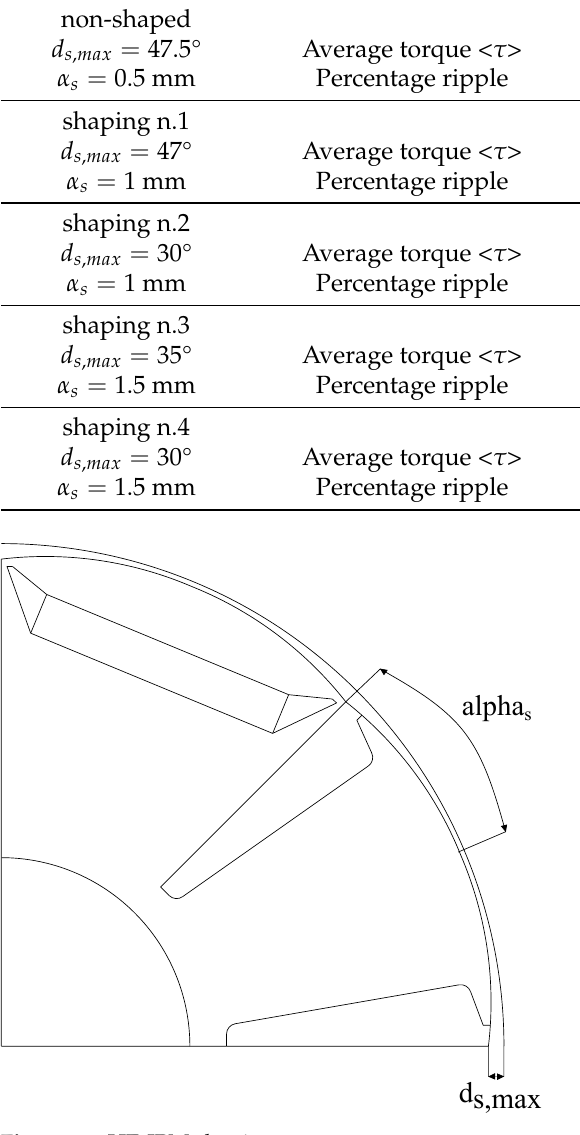
Figure 19. HE-IPM shaping